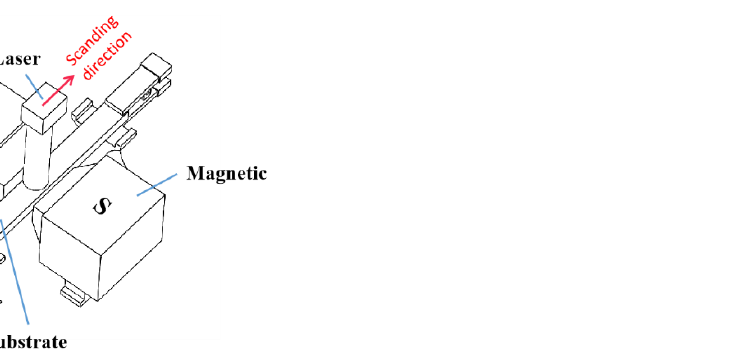
Figure 2. Schematic of experimental equipment for laser melting on 316L stainless steel.